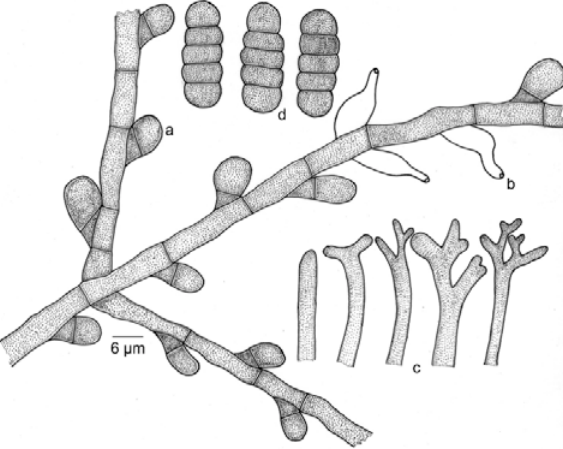
Figure 87. Meliola lepianthedis a - Appressorium; b - Phialide; c - Apical portion of mycelial